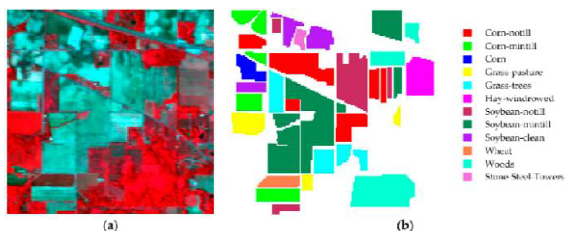
Figure 4. RGB map (a), Reference map (b) for Pavia University